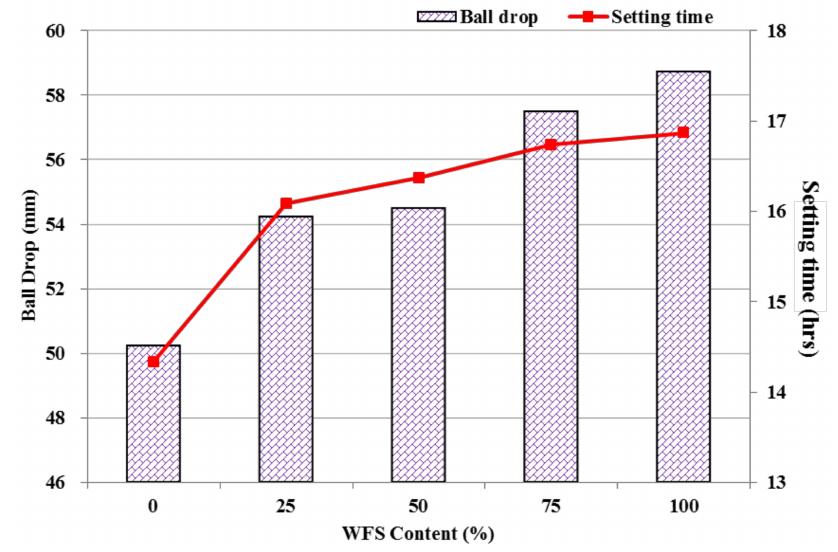
Figure 3. Effect of MSWI content on ball drop and setting